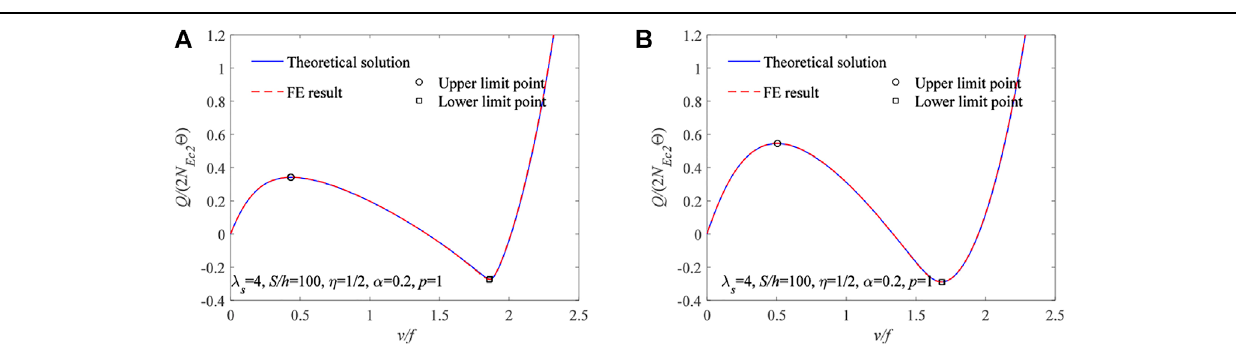
FIGURE 13 | ANSYS result and theoretical result of limit point instability for pin-ended FGM arches having different types of cross-section: (A) Type 1. (B) Type 2.